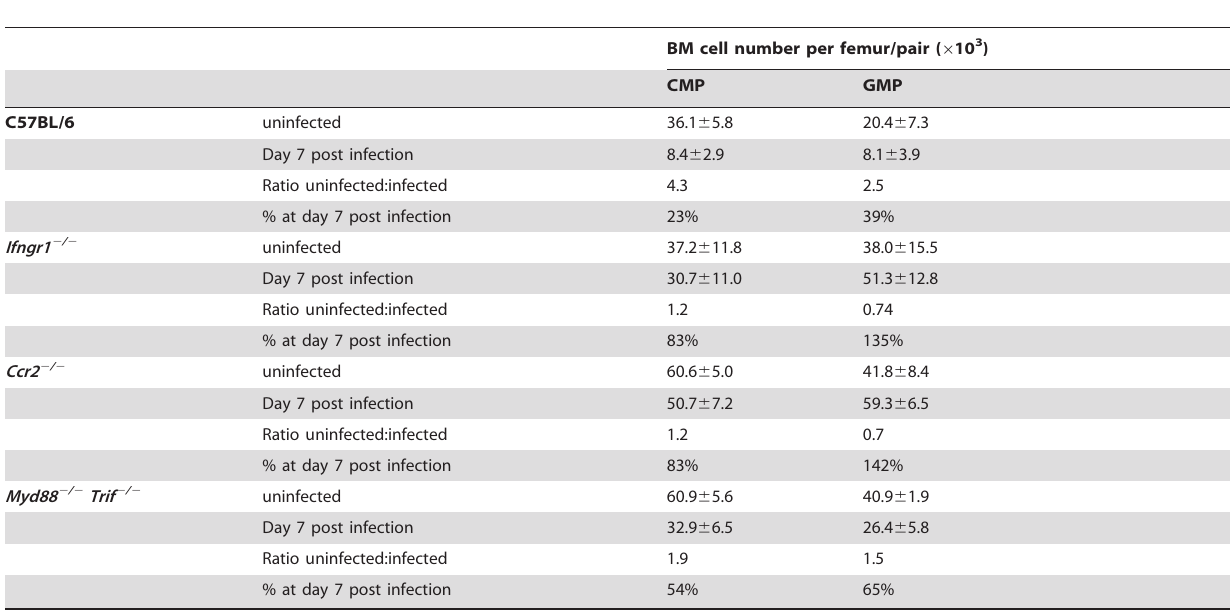
Table 1. Compilation of absolute numbers of CMP and GMP of bone marrow cells in steady state and at day 7 after infection with Plasmodium chabaudi in C57BL/6 mice and various mutant mouse